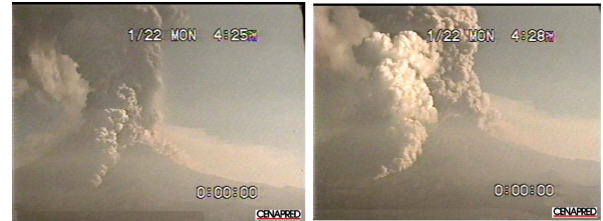
Figure 2. Photographs of 2001 eruptive activity. Pyroclastic flows flowed downslope, causing glacier melting and triggering the 2001 lahar (photographs taken from Espinasa Pereña,